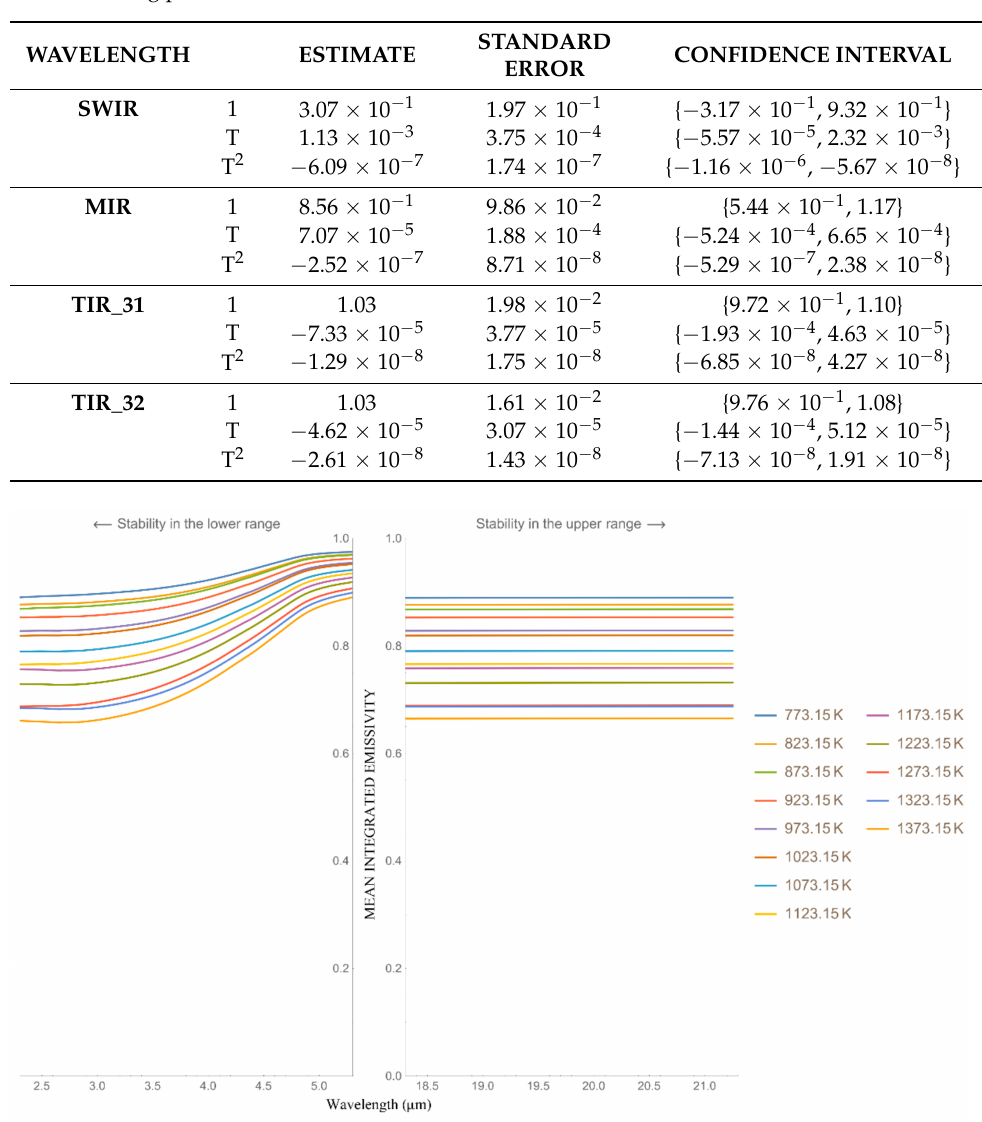
Table 1. Fitting parameters with associated standard error and confidence intervals.